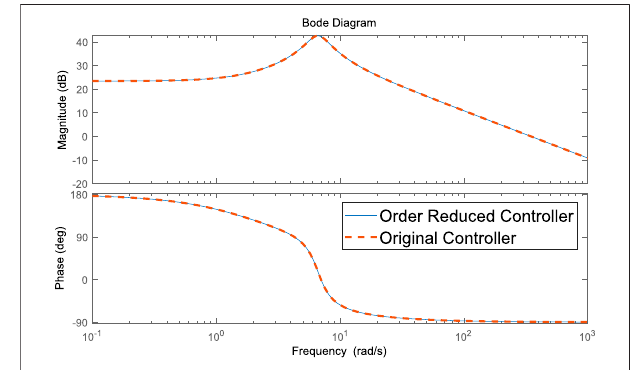
FIGURE 10 | Identi fi ed results for the active power-controlled system G P_system .